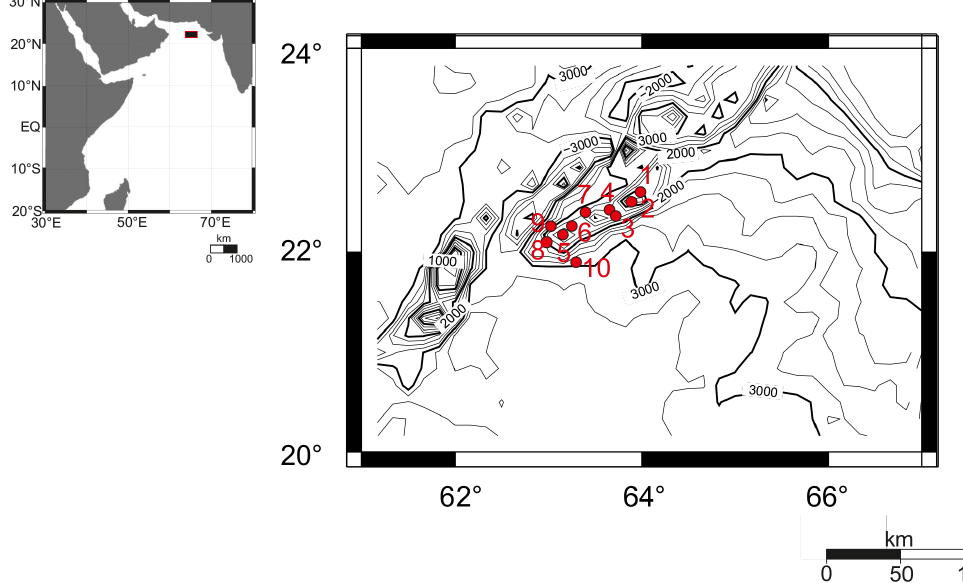
Fig. 1. Study area and station locations on the Murray Ridge, northern Arabian Sea. The black area on the regional map corresponds to the study